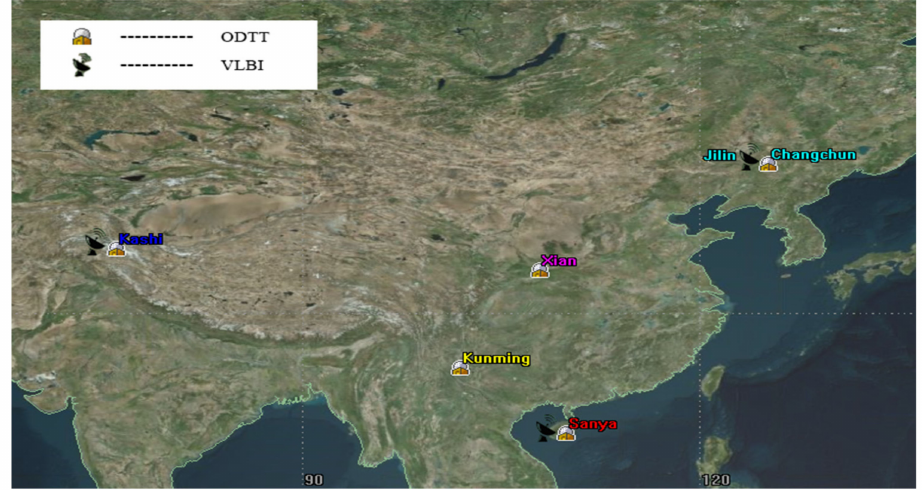
Figure 3. The distribution of